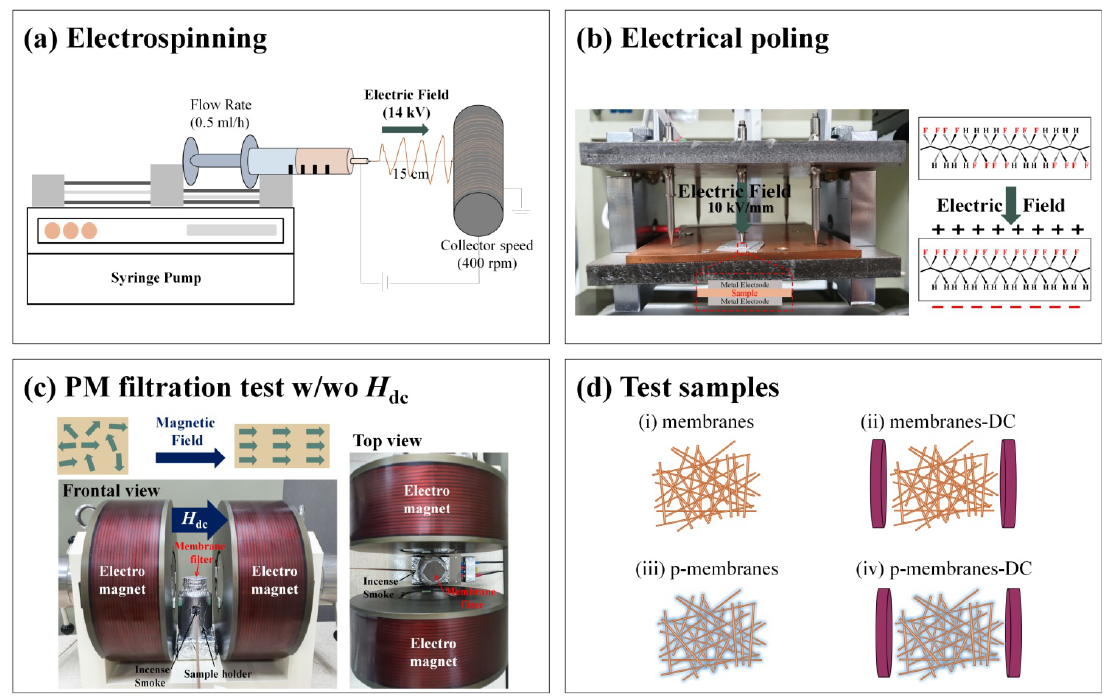
Figure 1. ( a ) Schematic illustration of the electrospinning process for the fabrication of poly(vinylidene fluoride)/CoFe 2 O 4 (PVDF/CFO) membranes, ( b ) poling process for beta-phase alignment in PVDF, ( c ) setup for particulate matter (PM) filtration test, and ( d ) four types of test samples; (i) PVDF/CFO membranes under H dc = 0 Oe (membranes), (ii) PVDF/CFO membranes under H dc = 700 Oe (membranes-DC), (iii) poled-PVDF/CFO membranes under H dc = 0 Oe (p-membranes), and (iv) poled-PVDF/CFO membranes under H dc = 700 Oe (p-membranes-DC).